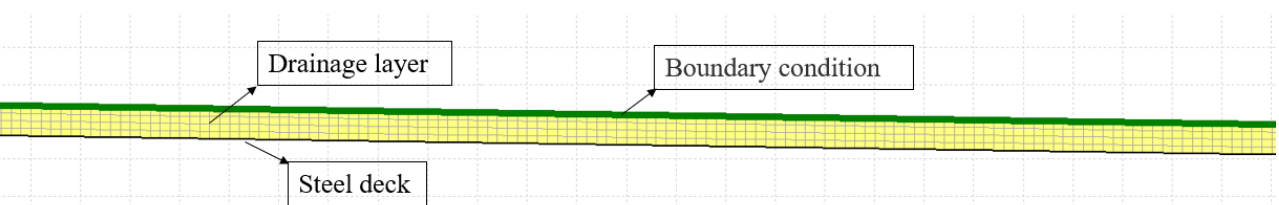
Figure 14. Partial schematic of the model.